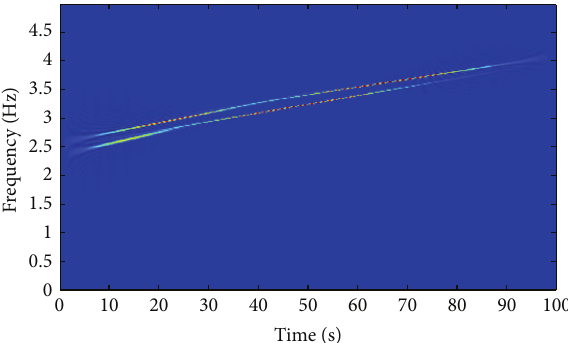
Figure 14: RSS with the increase of 𝑛 .